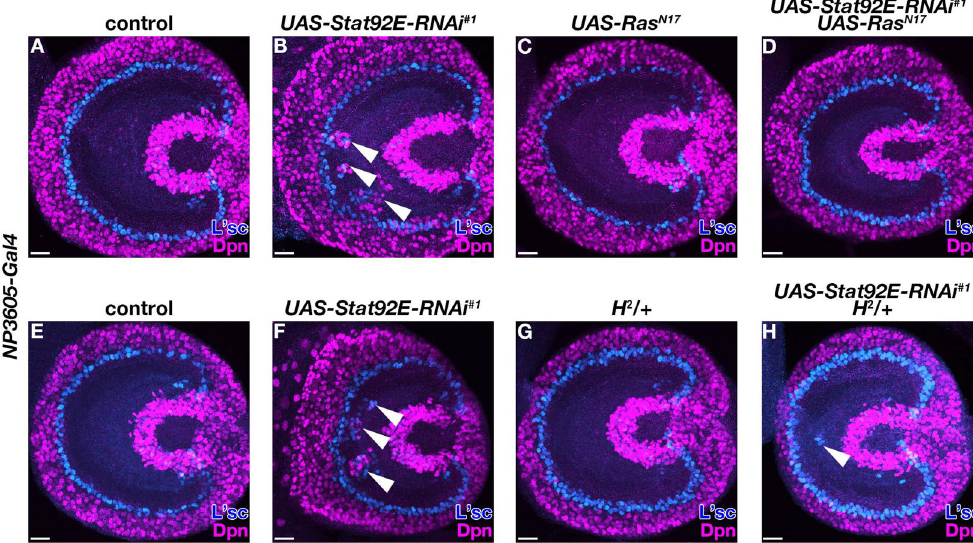
Figure 5. Noise canceling function of JAK/STAT is mediated by EGF and Notch signaling pathways. ( A – D ) Third-instar larval optic lobes for control ( A ), UAS-Stat92E-RNAi #1 ( B ), UAS-Ras N17 ( C ) and UAS-Stat92E- RNAi #1 , UAS-Ras N17 ( D ). ( E – H ) Third-instar larval optic lobes for control ( E ), UAS-Stat92E-RNAi #1 ( F ), H 2 heterozygous mutant ( G ) and UAS-Stat92E-RNAi #1 in the H 2 heterozygous mutant background ( H ). NP3605- Gal4 was used as a Gal4 driver. L’sc (blue) and Dpn (magenta) are shown. White arrowheads in ( B , F , H ) indicate ectopic L’sc and/or Dpn expression. Scale bars, 20 μ